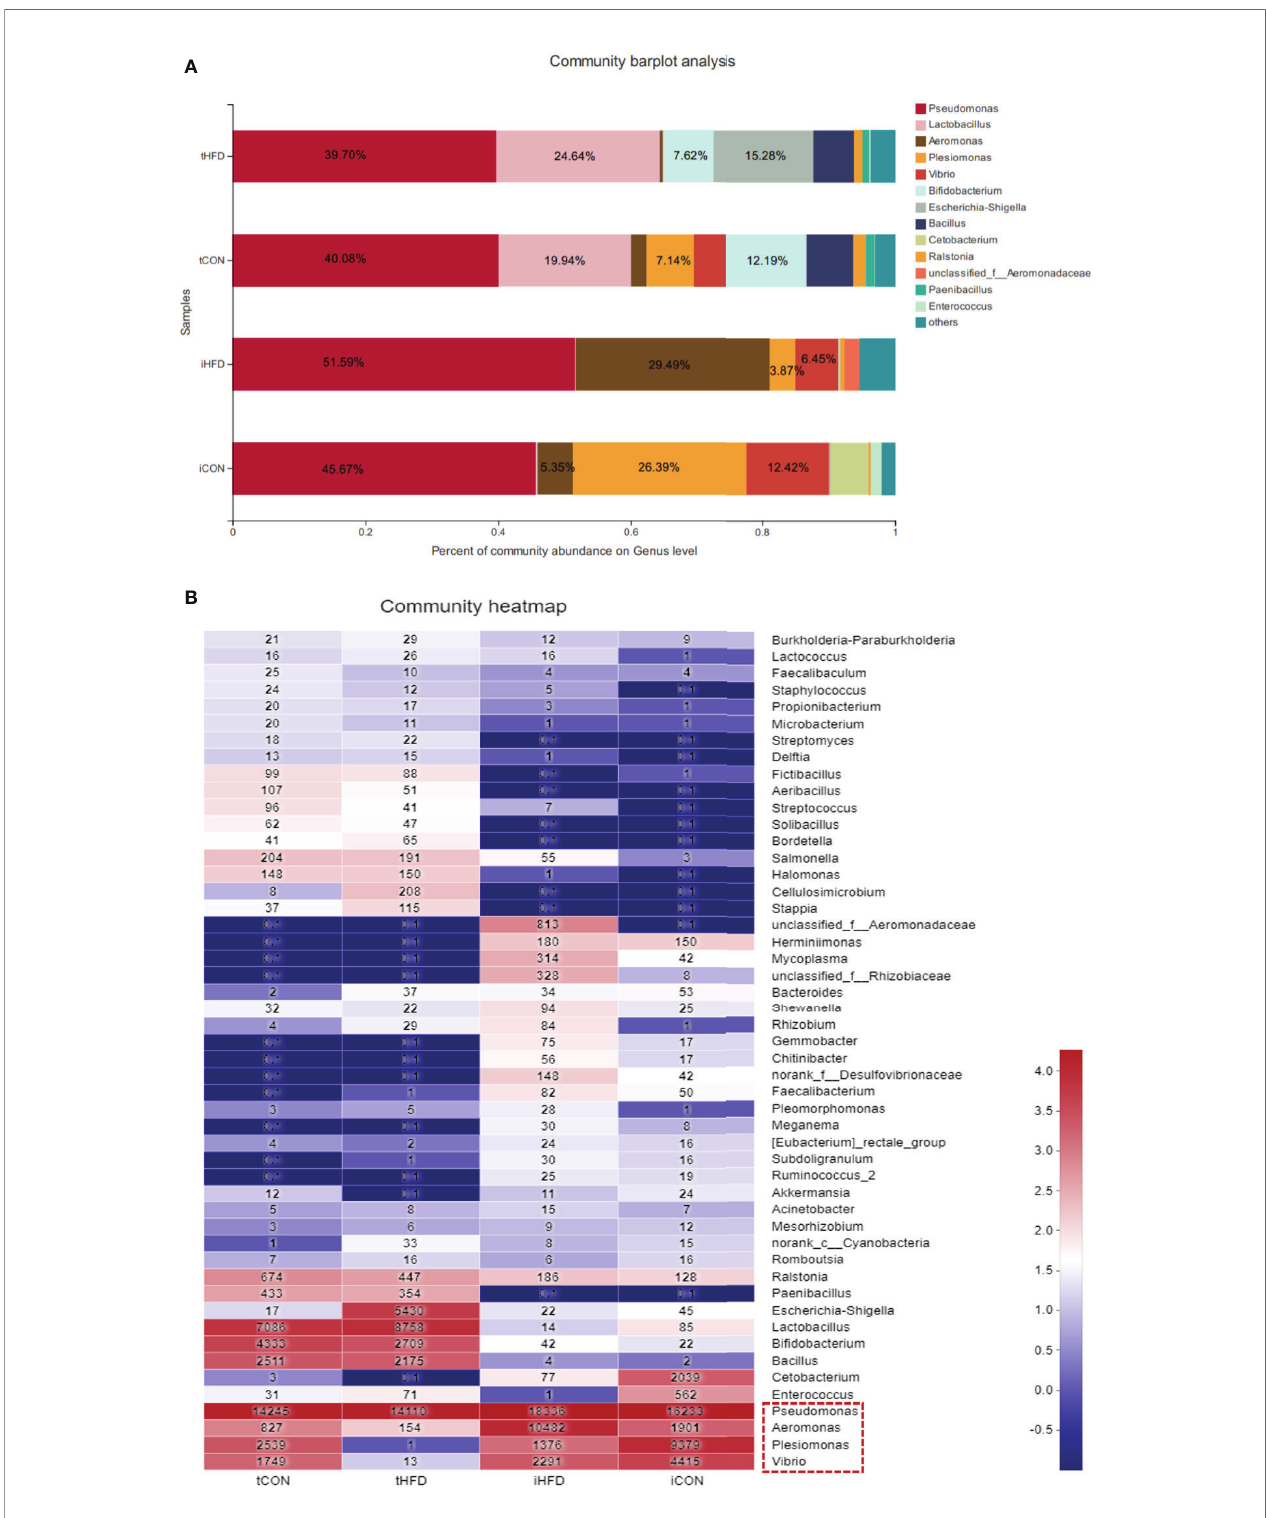
FIGURE 6 | Comparison between testicular and intestinal microorganisms. (A) Analysis of the microbial community composition of the testis and intestinal samples in the control and obese groups. The histogram results show that the dominant species are the same at the gate level for different samples, but the relative abundance is different. (B) The heatmap shows the species composition and sample cluster tree analysis of 50 species of bacterial communities in the testis and intestinal tracts of different groups at the genus level. Red indicates high bacterial abundance, whereas blue indicates low abundance. Data represent mean ± SME ( n =